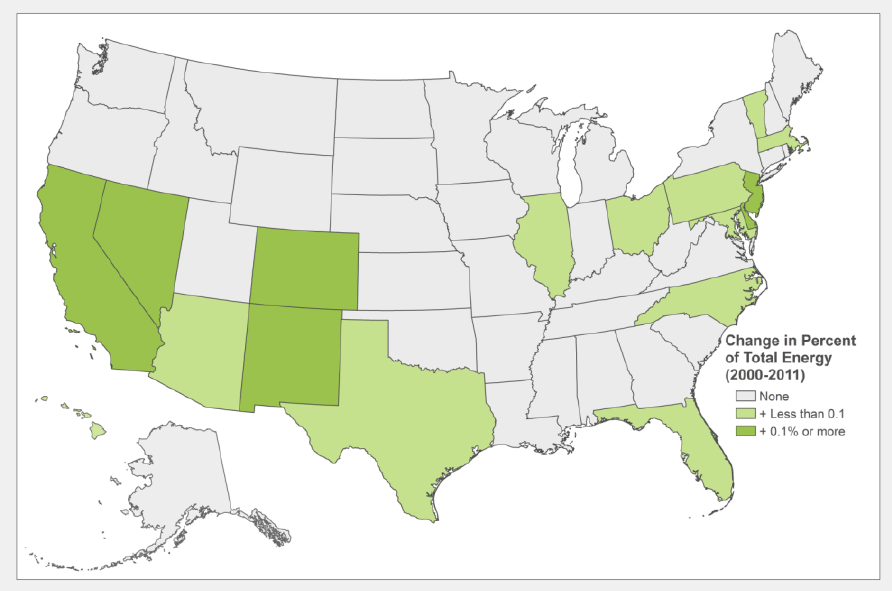
Figure 3. Change in percentage of total electricity produced from solar by state. This map presents the change in the percentage of a state’s total energy production coming from solar energy sources from 2000 to 2011 using data from the US EIA